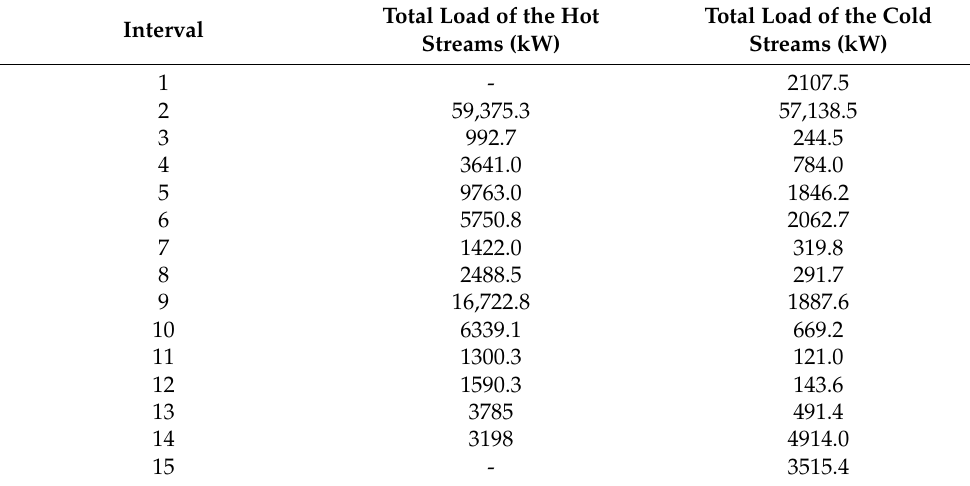
Table 5. The exchangeable heat loads of the process streams for each interval.